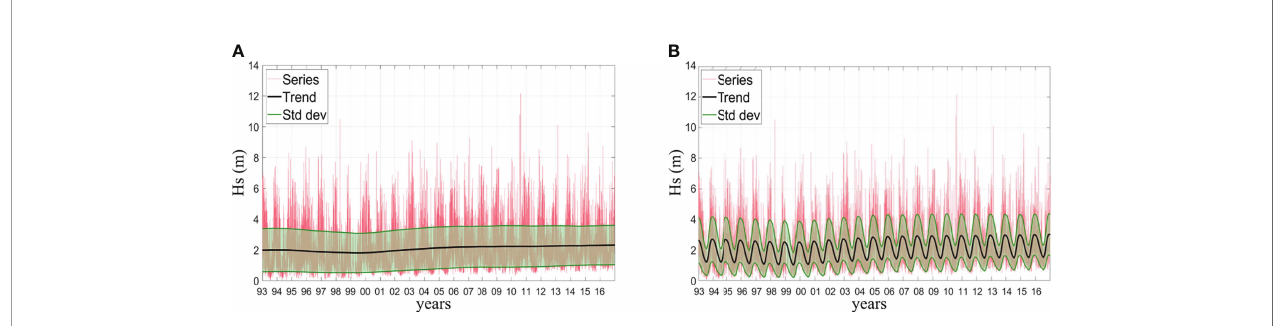
FIGURE 3 | TS-EVA of the projections of signi fi cant wave height for a point located in the Kara Sea. The time series of Hs (m), its long-term trend and standard deviation computed with a time window of 5 years obtained with (A) the nonseasonal approach and (B) with the seasonal